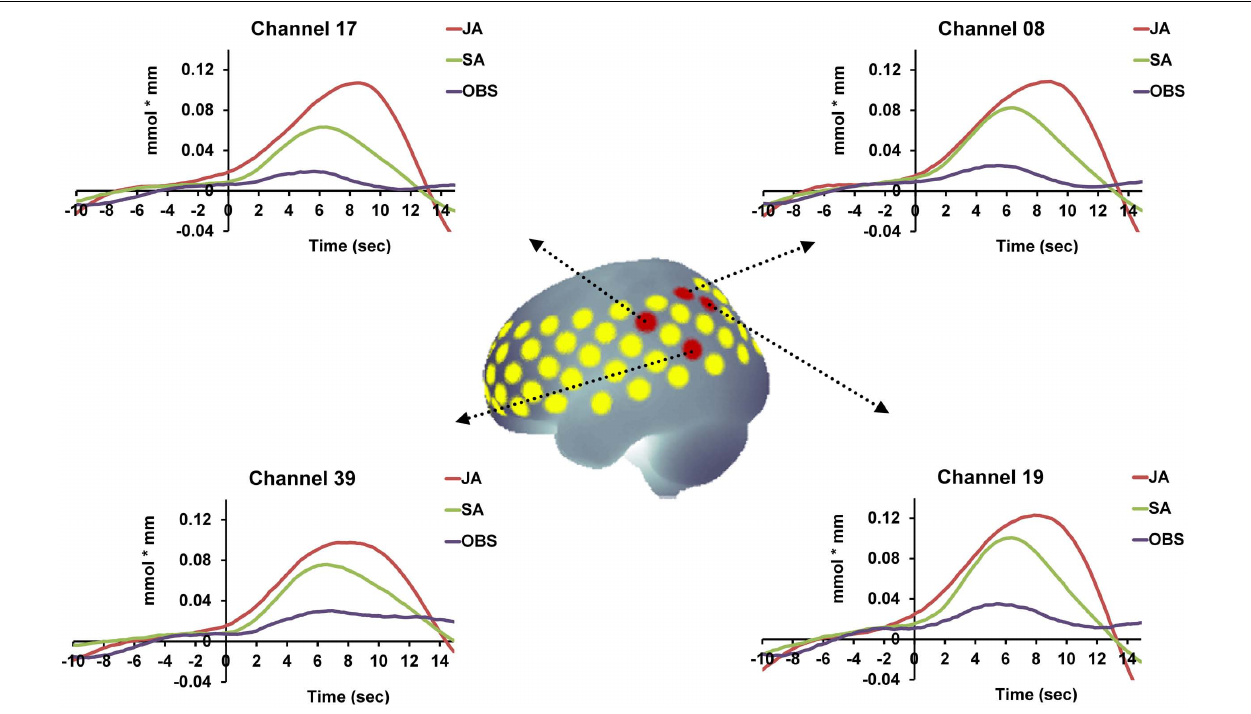
FIGURE 3 |Time course of the hemodynamic responses for OBS, SA, and JA exemplified for those areas that were involved in real-life joint action and that demonstrated the functional properties of action simulation areas [(JA > SA), (OBS > baseline), and (SA > baseline), p FDR < 0.05]. The red dots mark the anatomical location of the relevant channels.